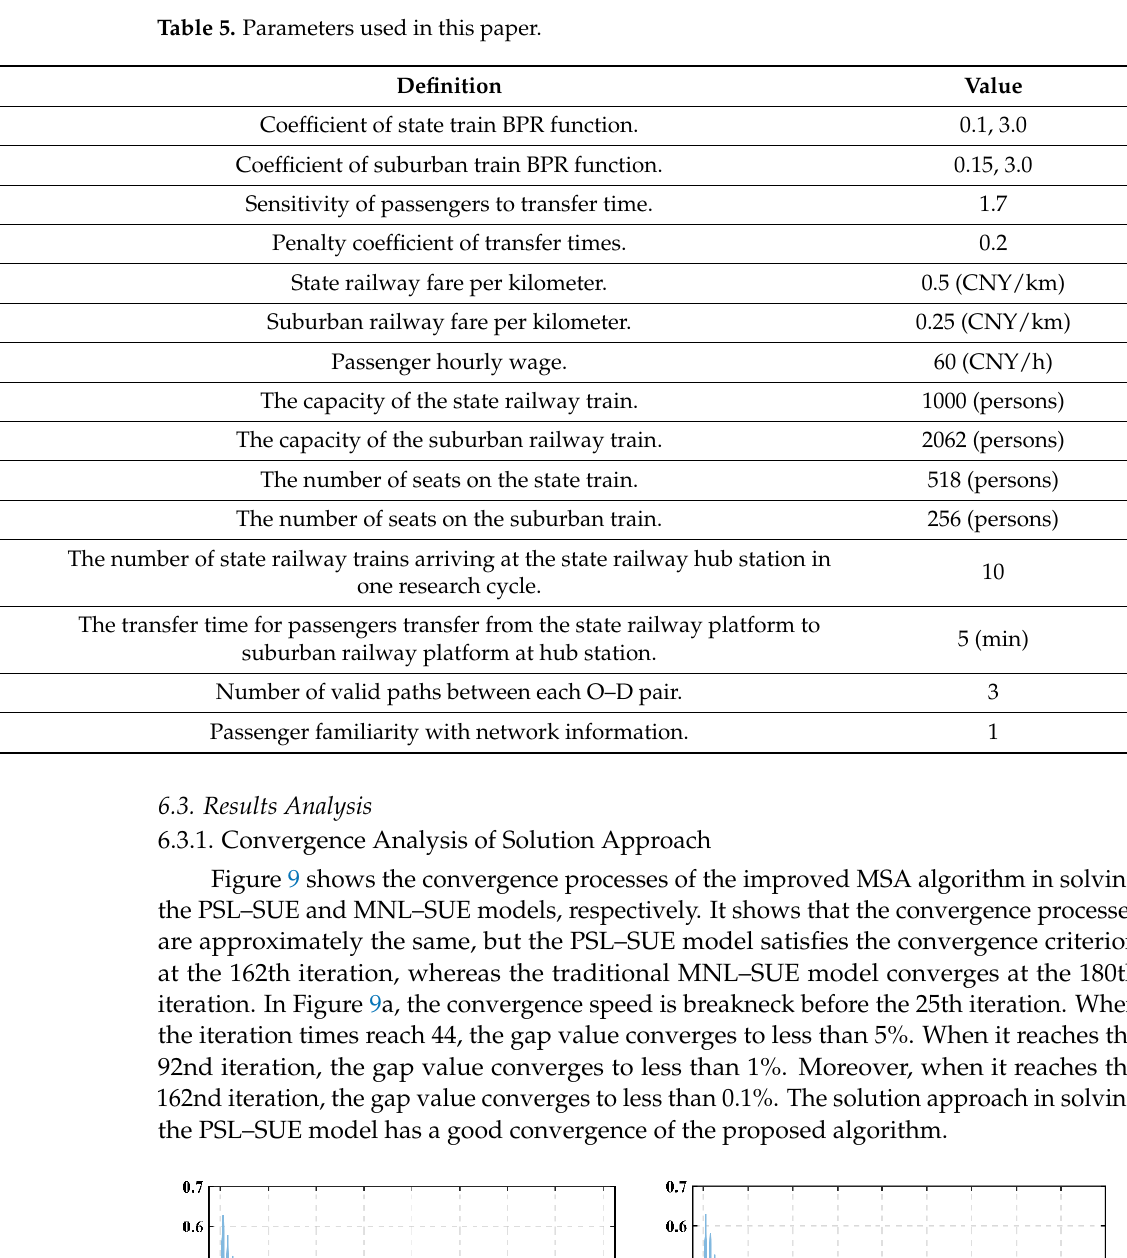
Figure 10. Passenger assignment result. Table 6. Comparison of solution results between PSL–SUE model and MNL–SUE model. Train